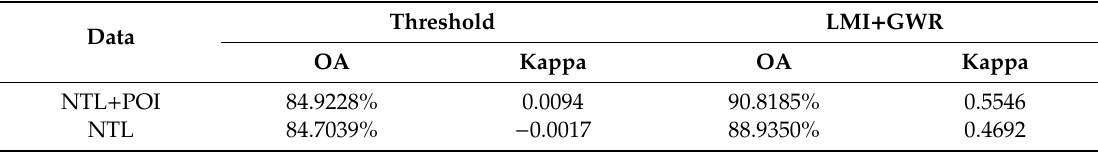
Table 1. Overall accuracy (OA) and kappa coefficient of four types of results.